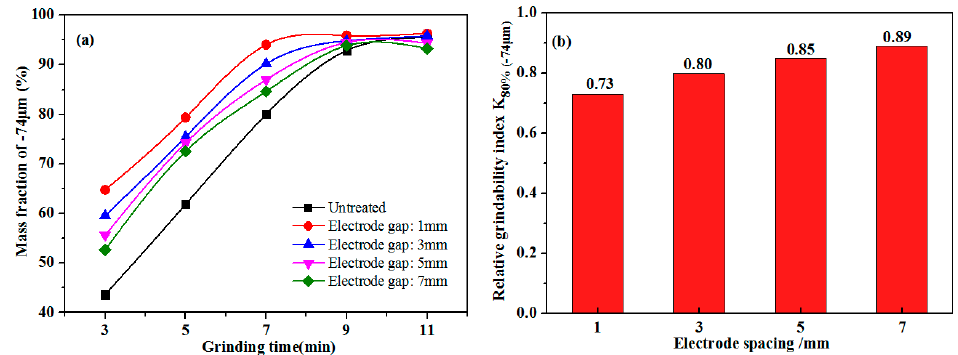
Figure 7. The effect of the electrode spacing on ( a ) mass fraction and ( b ) grindability index.